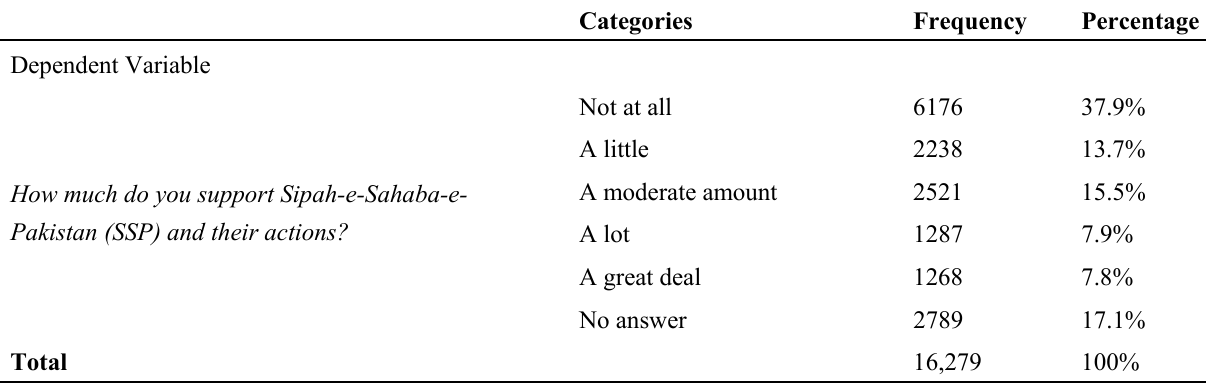
Table 2. Summary Statistics of Dependent and Independent